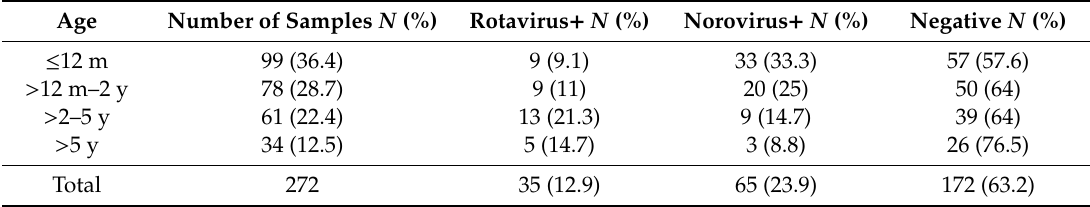
Table 1. Distribution of children infected with rotavirus and noroviruses according to age